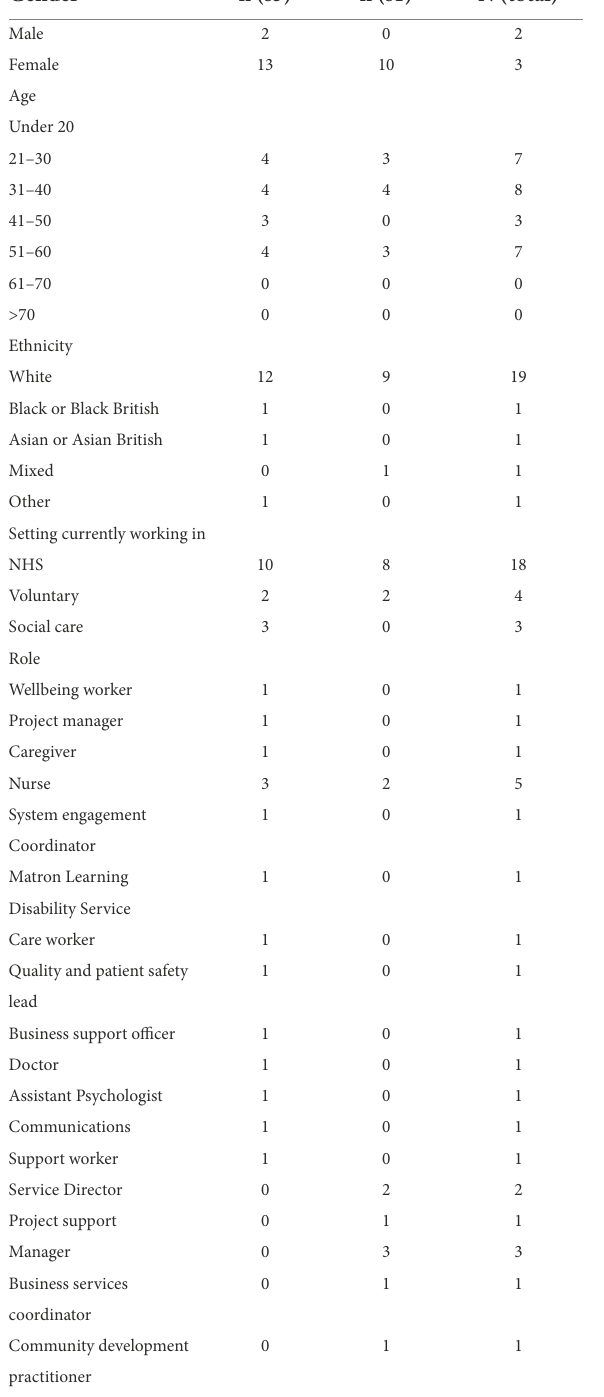
TABLE 1 Participant demographics ( n =